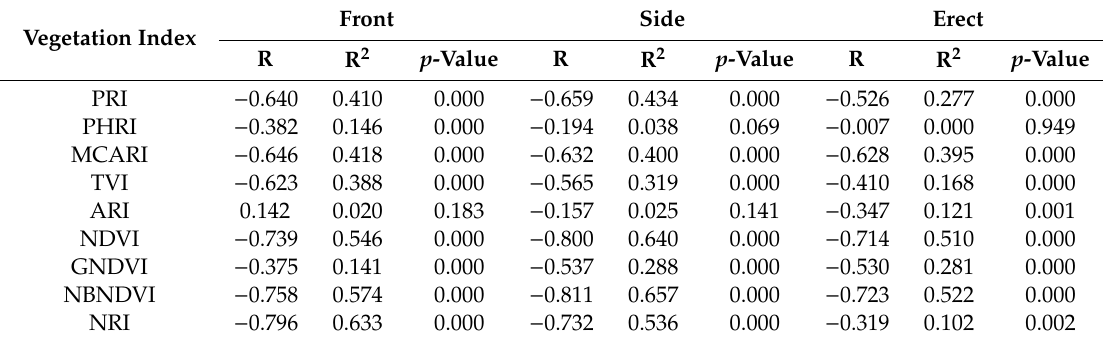
Table 7. Correlation between vegetation indices and disease